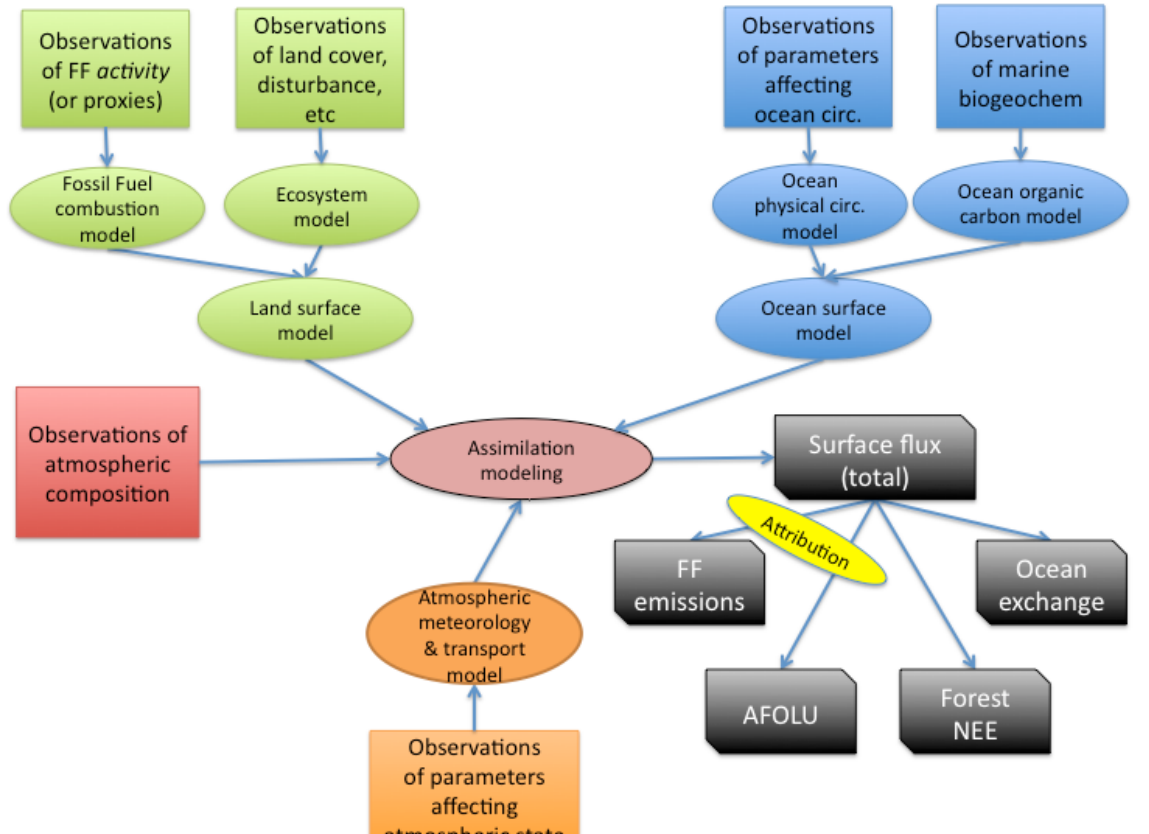
Figure 9. Conceptual illustration of a global carbon-cycle data assimilation system relying on operational carbon-cycle flux and pool mea-